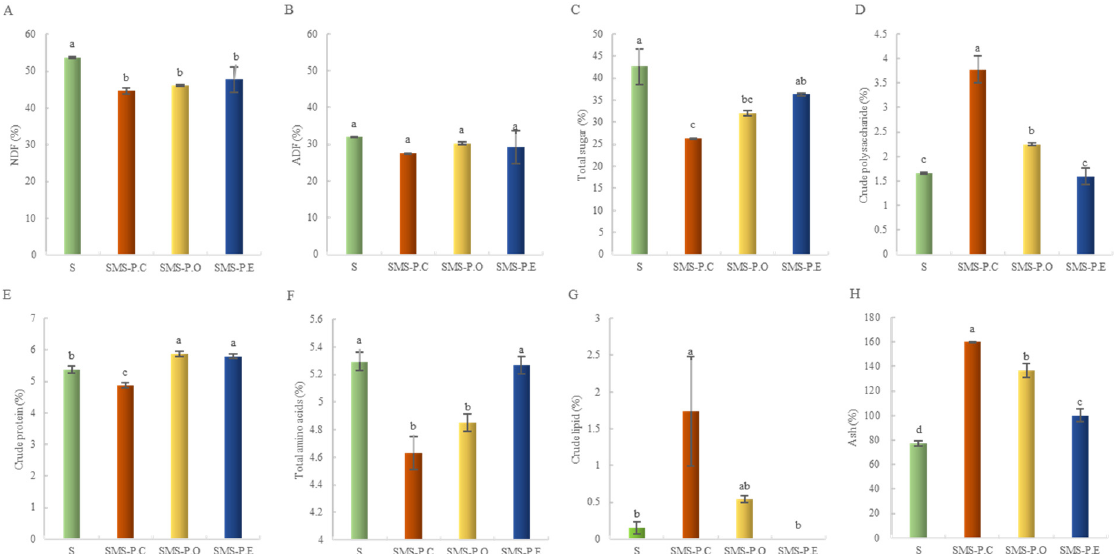
Figure 1. The contents of neutral detergent fiber (NDF) ( A ), acid detergent fiber (ADF) ( B ), total sugar ( C ), crude polysaccharide ( D ), crude protein ( E ), amino acids ( F ), crude lipid ( G ), and ash ( H ), in substrate (S) and spent mushroom substrates (SMS). Notes: SMS-P.C, SMS-P.O, and SMS-P.E indicated SMS from P. eryngii , P. ostreatus, and P. citrinopileatus. The diverse letters indicated significant difference at 0.05 level.